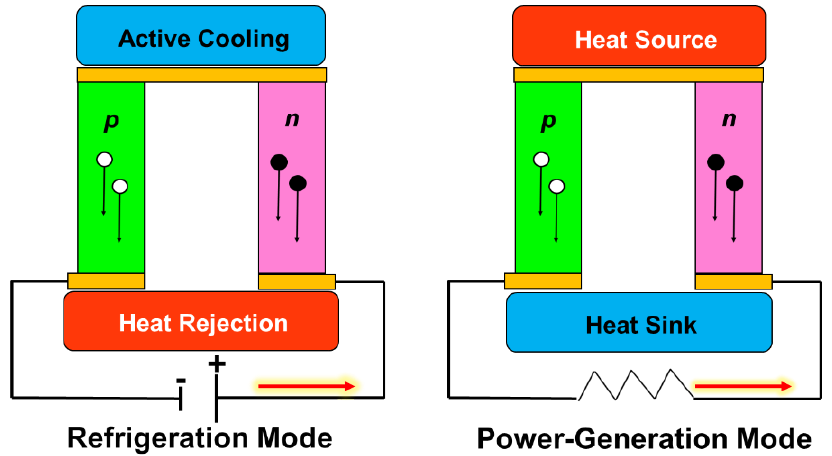
Figure 3. Working principle of TE materials in refrigeration and power generation modes.